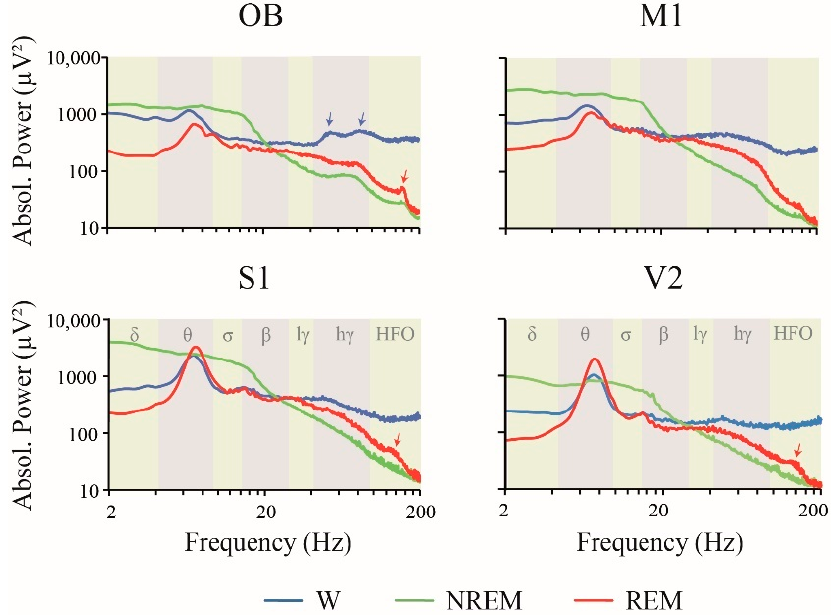
Figure 2. Power spectral profiles. Mean absolute power spectral profiles of the right hemisphere in wakefulness (W), NREM and REM sleep during the light period ( n = 11). The frequency bands used for the statistical analysis are indicated by different colors in the background of the graphics. Blue arrows show two small deflections in the HG band during W and red arrows demonstrate a narrow peak in HFO at ≈ 130 Hz that can be appreciated during REM sleep in OB and somatosensory cortices. OB, olfactory bulb; M1, primary motor cortex; S1, primary somato-sensory cortex; V2, secondary visual cortex; W, wakefulness; r, right; l, left; l γ , low gamma or LG; h γ , high gamma or HG; HFO, high frequency oscillations.